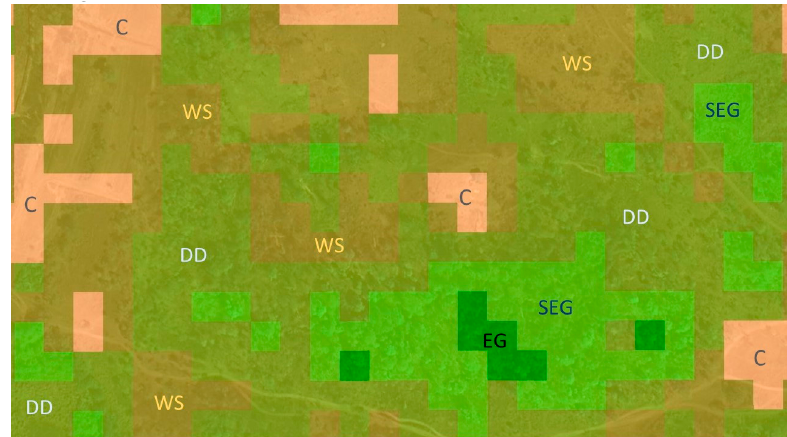
Figure 8. Visualization of the basic concepts of the accuracy assessment applied in this study: The pixels with different color codes are the resulting maps of OLI, and the overlaid background image is an ArcGIS VHR image. The labeled names on the map are as follows: EG: Pixels representing evergreen forest with 90%–100% tree cover and closed crown cover; SEG: Semievergreen forest with 50%–80% tree cover and dense crown cover; DD: Deciduous forest with 20%–50% tree cover and sparse crown cover; WS: Mixed wood and shrublands, with minimal percentages of EG and DD tree cover and large areas covered by bush or grass or crops; C: Pixels representing croplands or pixels with no tree cover.